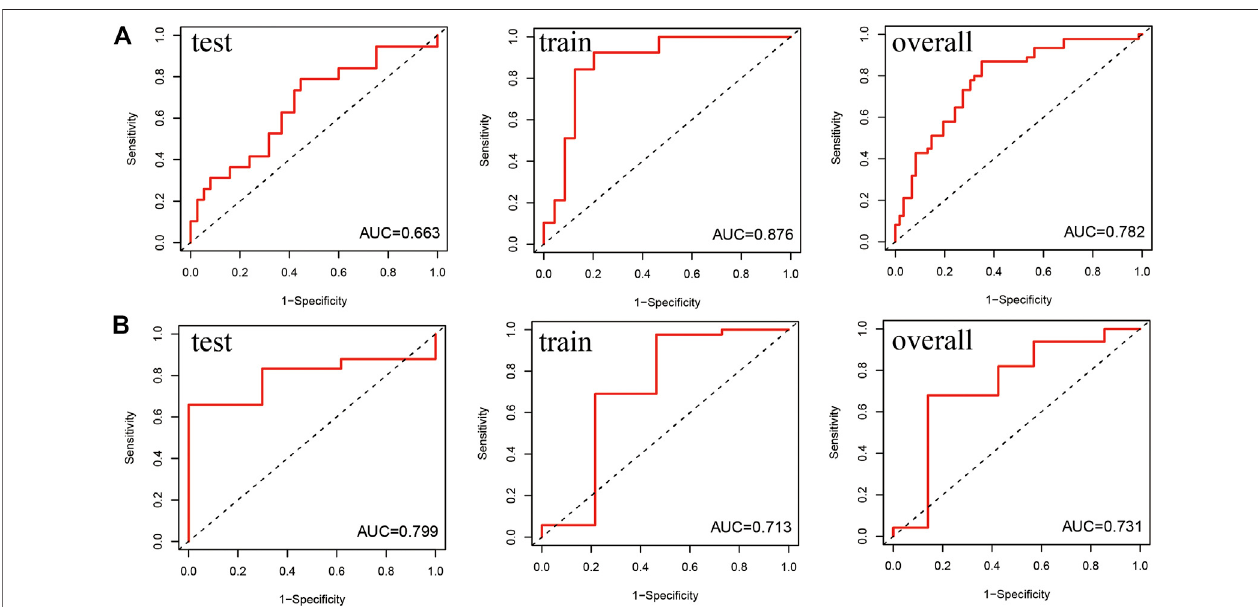
FIGURE5| Receiveroperatingcharacteristic(ROC)curveofthepredictionef fi ciencyofthetrain,test,andoverallgroups.TheX-and Y -axesrepresent1-speci fi city and sensitivity, respectively. Corresponding ROC curve of the (A) 1-year survival rate and (B) 5-year survival rate.